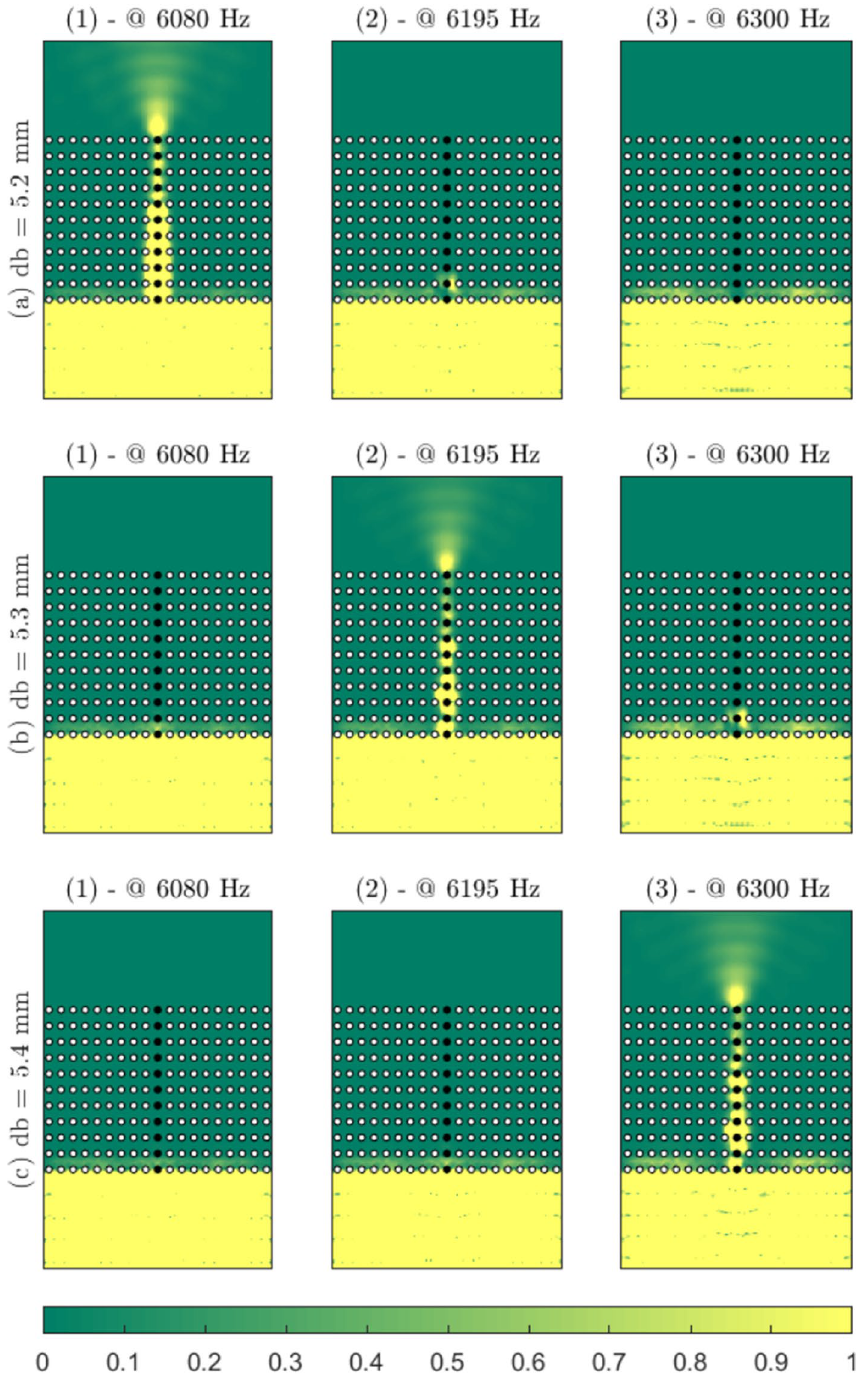
Figure 3. Normalized intensity maps for the three-designed waveguides (normalized by maximum transmitted intensity for each simulation box). The white points represent the 5.5-mm-diameter beams of the cluster, and the black points indicate the 5.2 mm ( a ), the 5.3 mm ( b ), and the 5.4 mm ( c ) diameter beams of the central line. From top to bottom ( a – c ): increasing the beam diameter of the central line increases the frequency of the flexural resonance and tunes the leakage through the beam